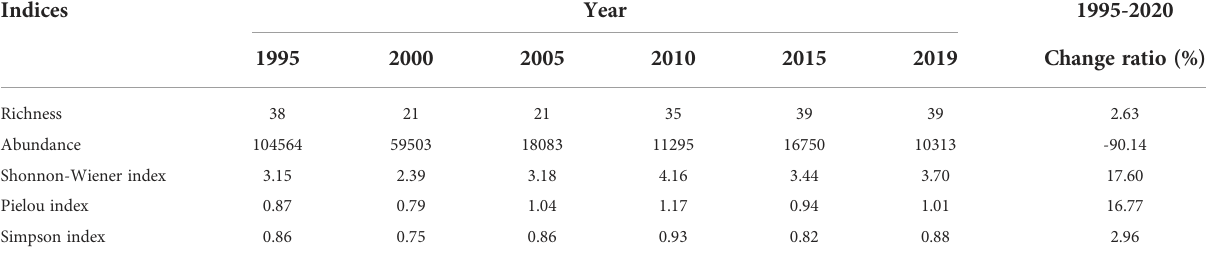
TABLE 3 Changes in richness, abundance, Shannon-Wiener index, Pielou index, and Simpson index between 1995 and 2020 in the Yellow River Delta. Indices